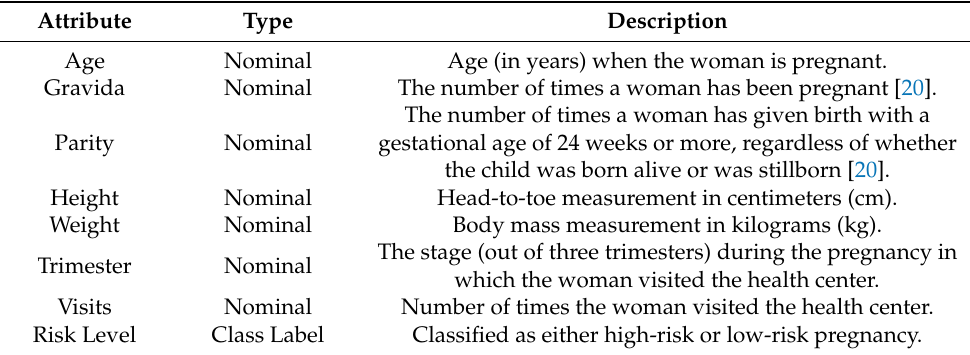
Table 2. Dataset attribute (predictors and class label), data types, and description. Attribute Type Description